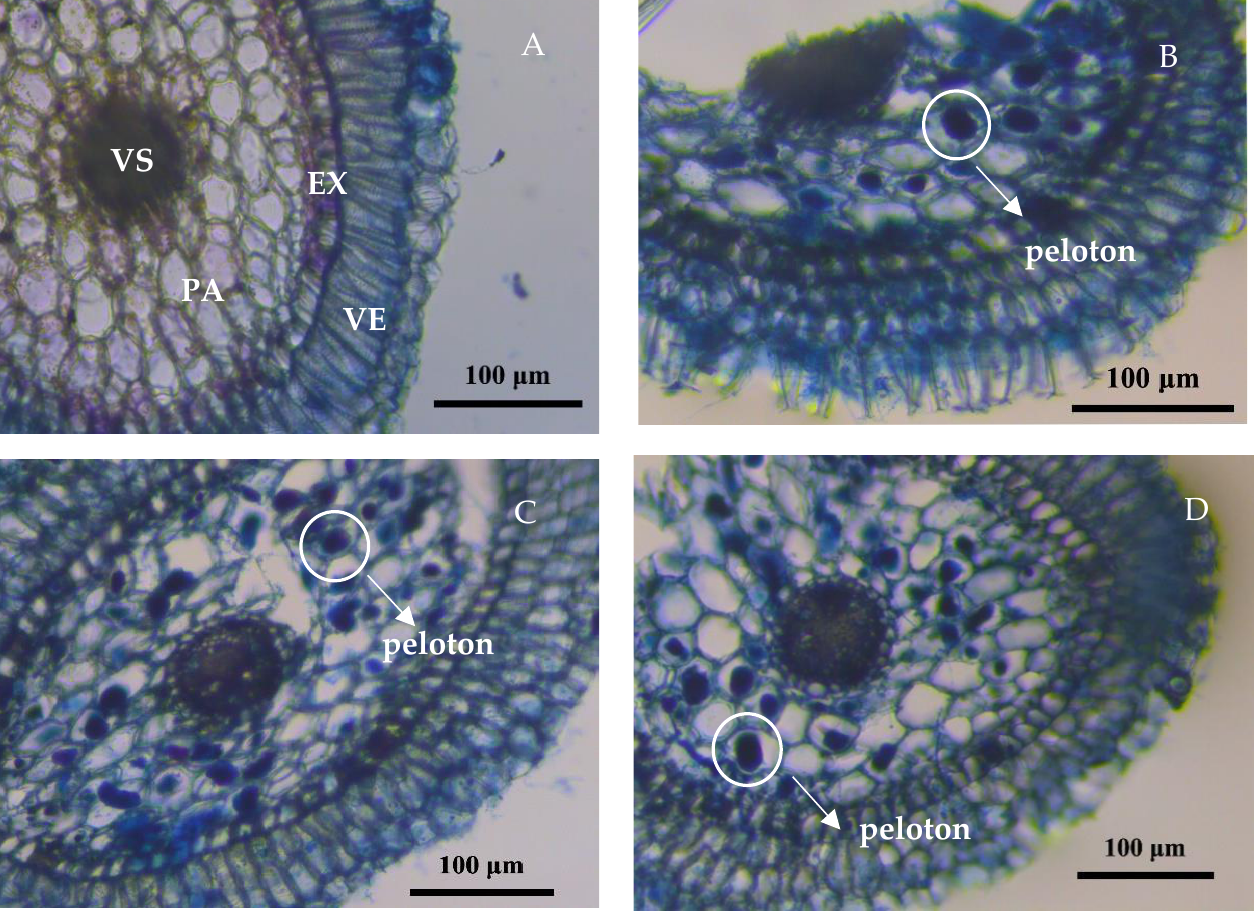
Figure 1. Determination of fungal colonization in the roots of D. officinale with trypan blue staining under a 20 × microscope. ( A ) represents the control group CK, ( B ) represents DSs ( Serendipita sp. from D. officinale ), ( C ) represents CTc ( T. calospora from C. goeringii ) and ( D ) represents ETa ( T. asymmetrica from E. radicans ). The white circle represents partial peloton in the root. VS: vascular bundle sheath; EX: exodermis; PA: parenchyma; VE: velamen.